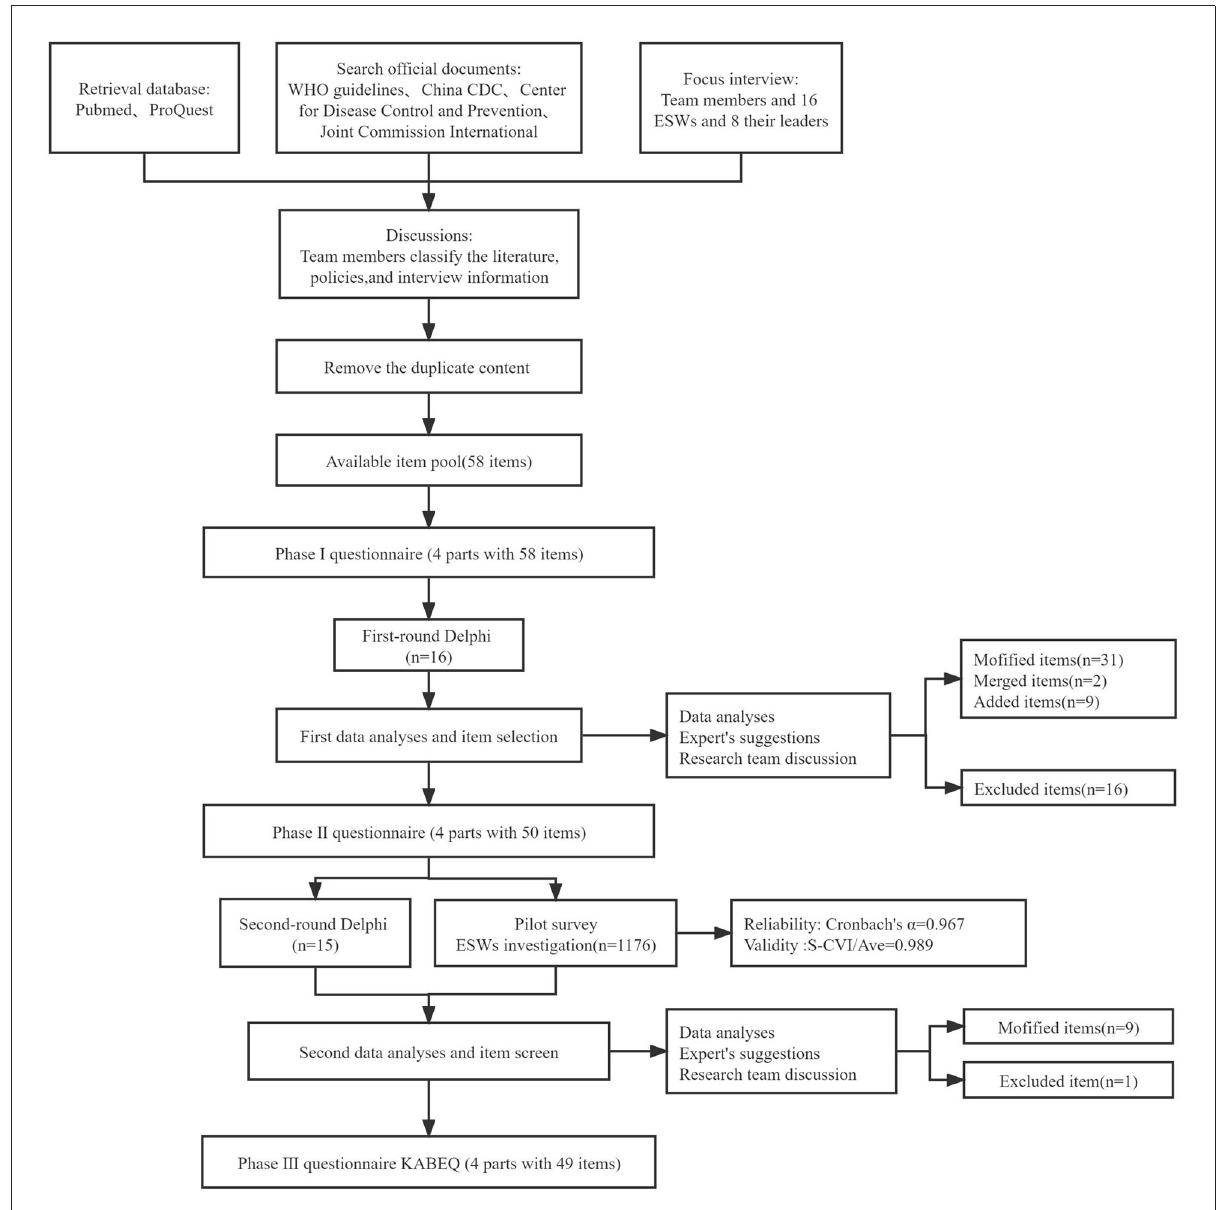
FIGURE2 Flow chart of the development